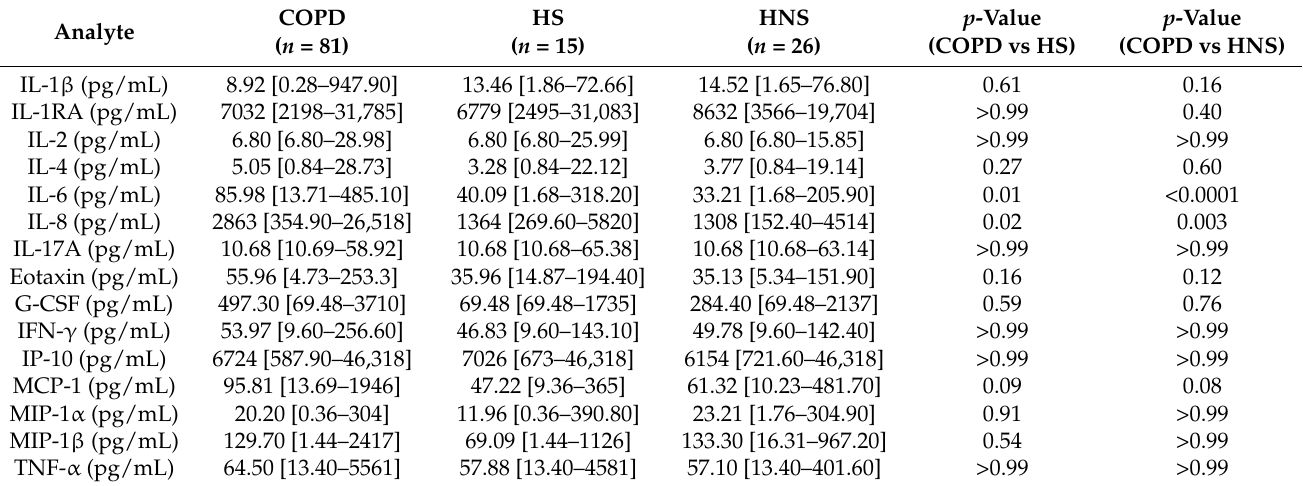
Table 4. Sputum Supernatant Cytokines for COPD subjects, healthy smoking and healthy non- smoking controls in Cohort B ( n = 81, 15 and 26,